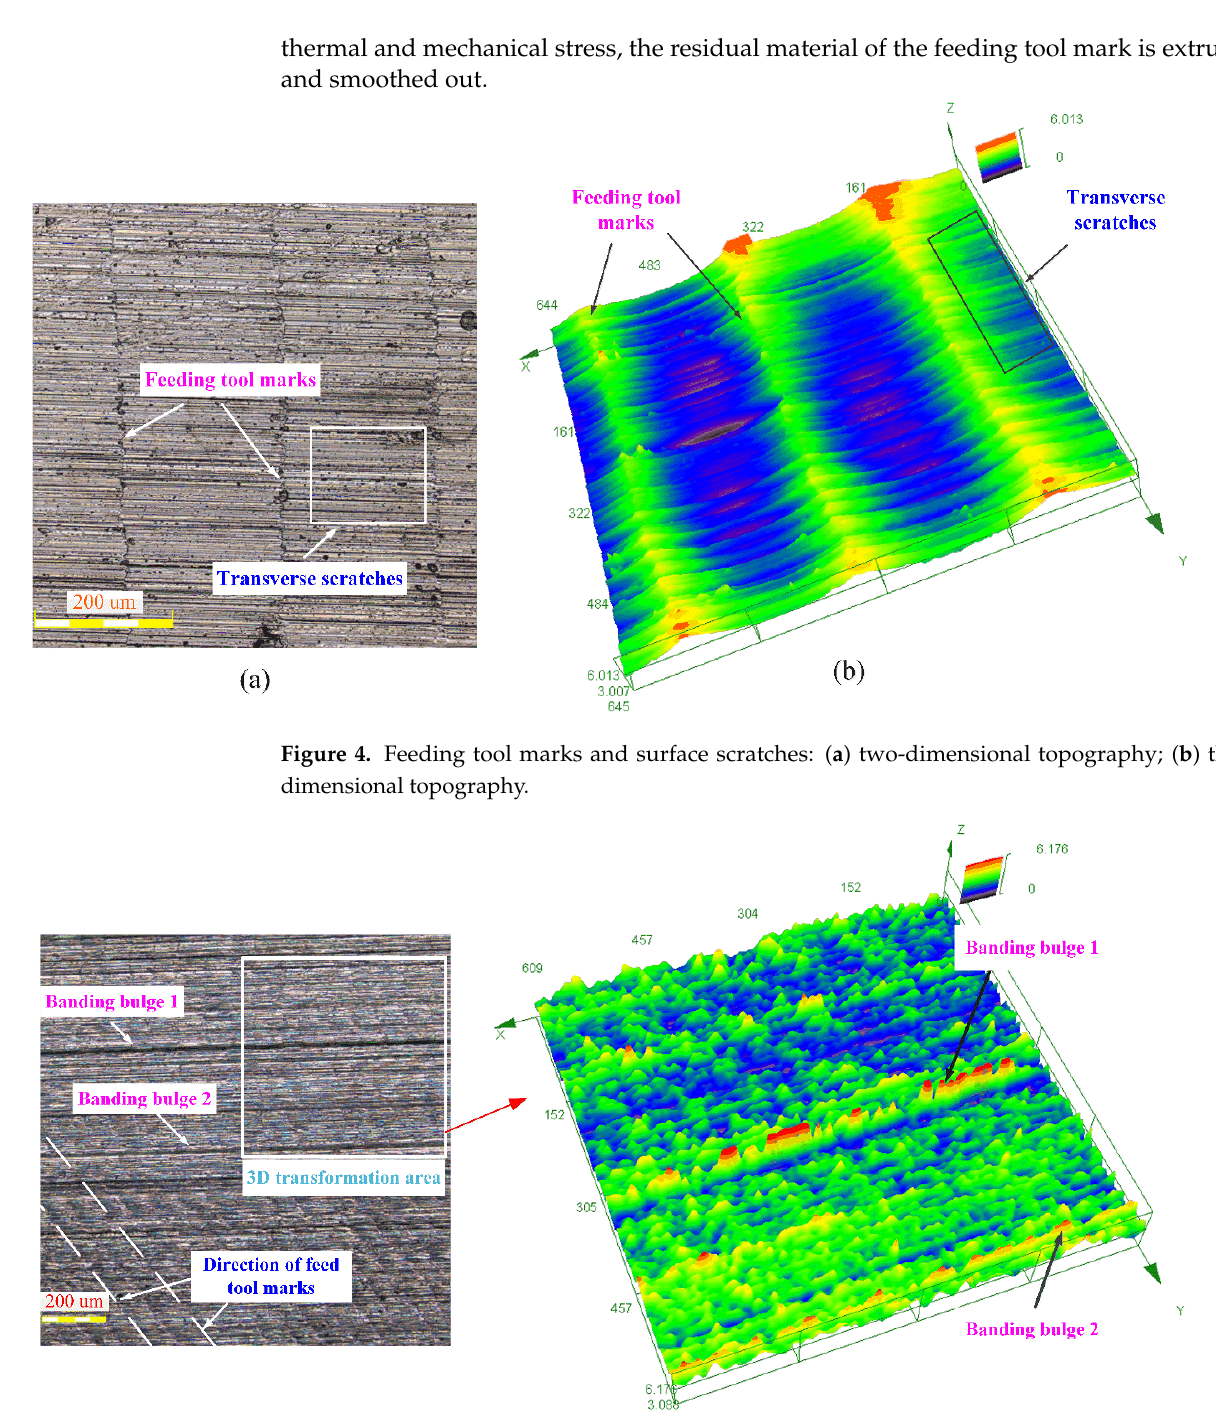
Figure 5. Banding bulges of the milled surface.